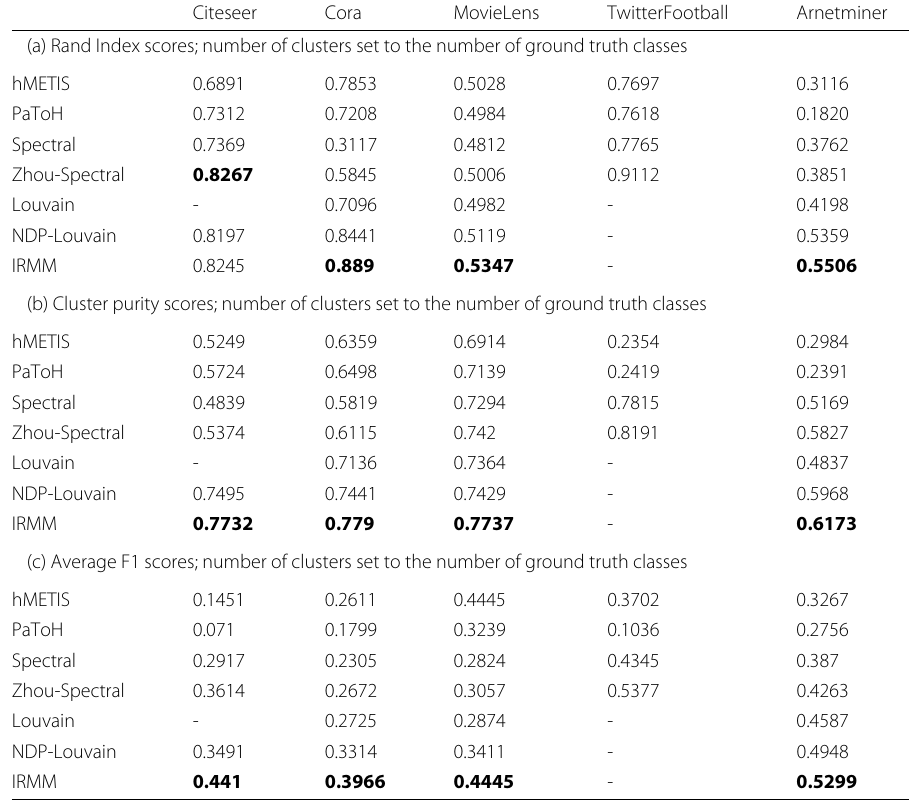
to the number of ground truth classes Citeseer Cora MovieLens TwitterFootball